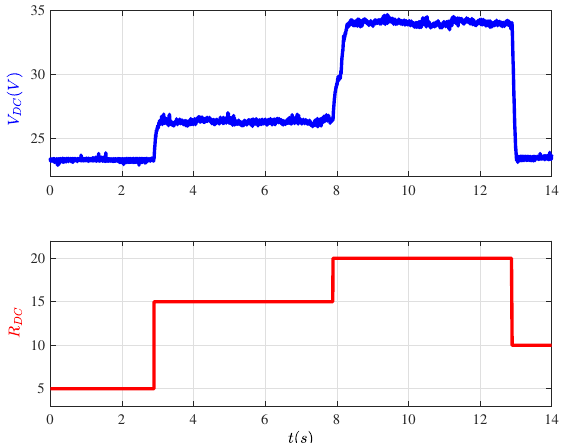
Figure 9. Influence of the load on the DC bus voltage. The other parameters are set to: I ref = 16 A, ψ = 180 ◦ , θ p = 150 ◦ , and ω = 800